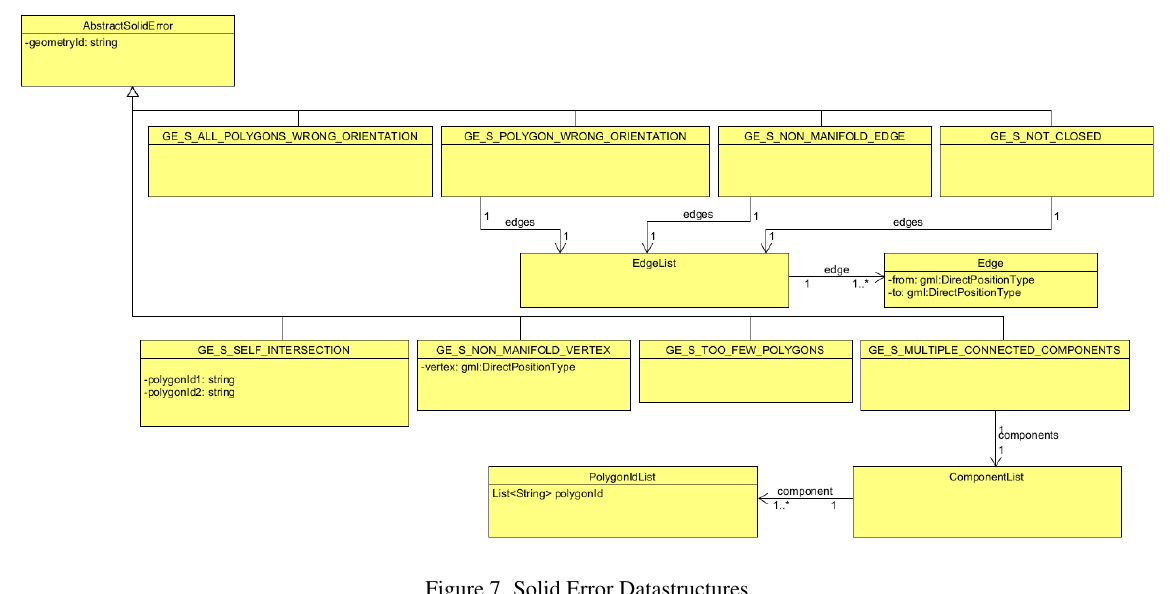
Figure 7. Solid Error Datastructures